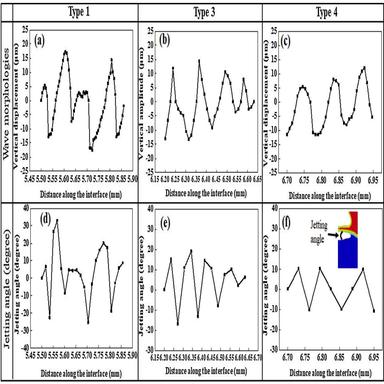
(a), (b) and (c) present wave morphologies of Type 1, 3 and 4 obtained by image analysis using micrographs; (d), (e) and (f) are the predicted jetting angle from Eulerian simulation corresponding to wave Type 1, 3 and 4, respectively. The inset in (f) explains the jetting angle calculation from the simulation.